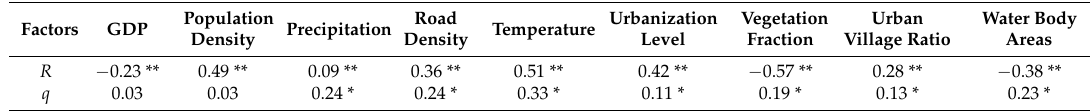
Table 1. Spatial association between socio-ecological factors and dengue fever